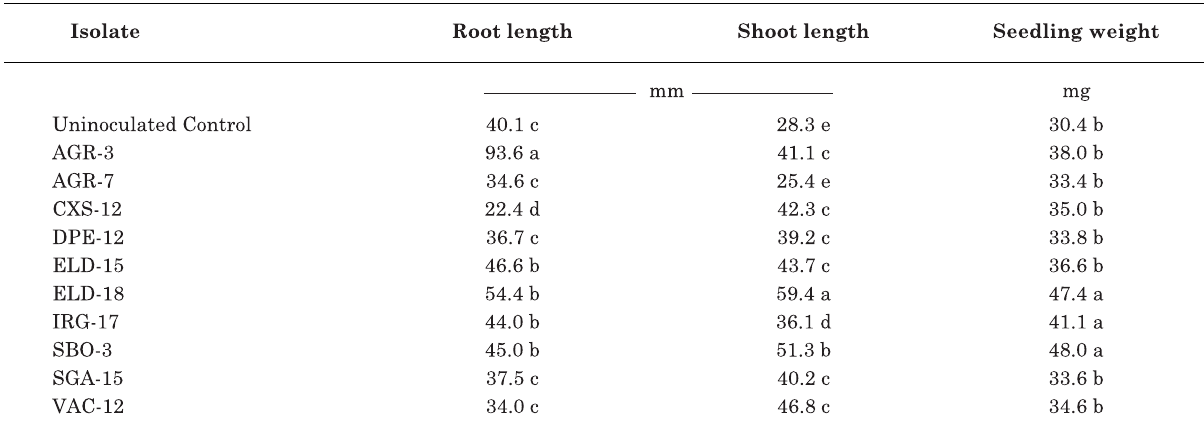
Table 4. Root and shoot length and dry matter of rice seedlings inoculated with R . leguminosarum biovar trifolii